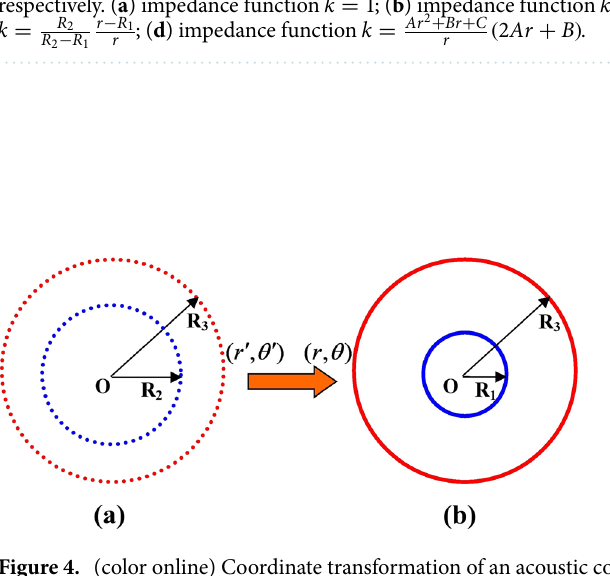
1 ; ( b ) impedance function k =